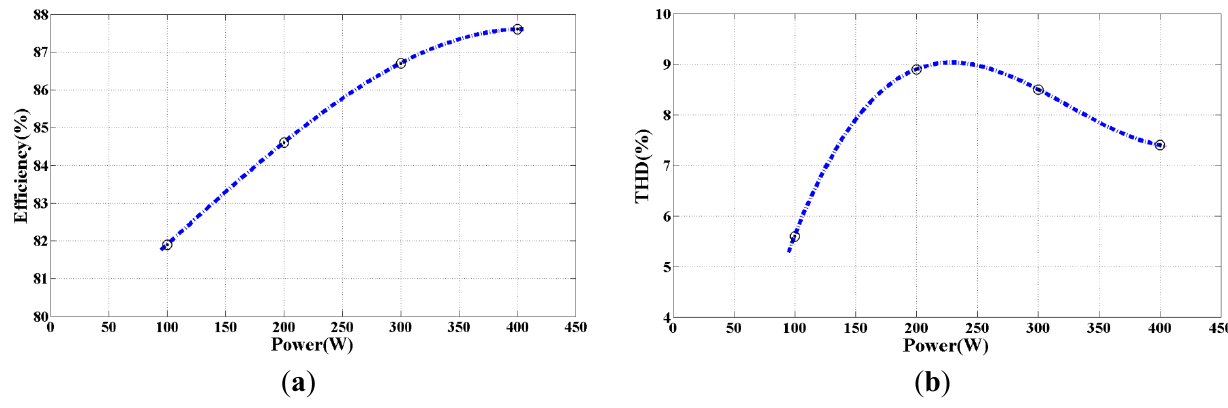
Figure 22. Relationship between efficiency/THD and output power. ( a ) measured efficiency; ( b ) measured